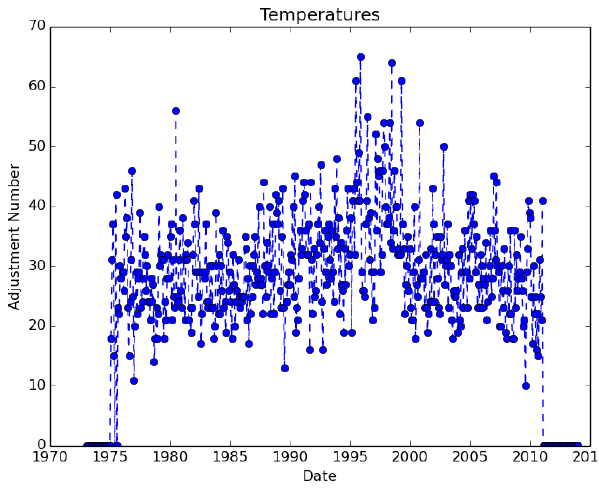
Figure 3. The number of change points found in each year Fig. 3. The number of change points found in each year from both from both the calculation methods (monthly-mean temperature and the calculation methods (monthly mean temperature and monthly monthly-mean diurnal temperature mean diurnal temperature range).